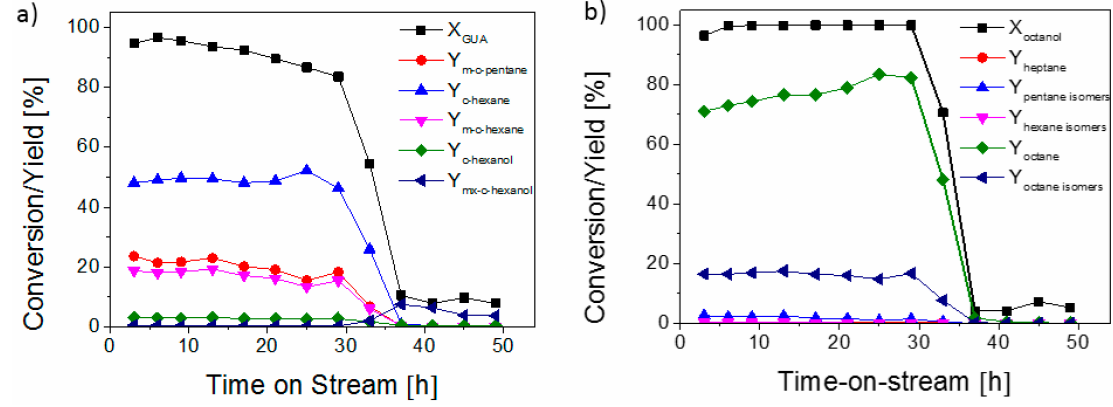
Figure 3. Conversion of ( a ) guaiacol and ( b ) 1-octanol over 1 wt. % Pt/H-MFI-90 as a function of time-on-stream (conditions: 0.3 mL/min 5% GUA in 1-octanol, 500 mL/min 80% H 2 /N 2 , T = 250 °C, p = 100 bar, 1 g catalyst; GUA = guaiacol, m = methyl, mx = methoxy, c =